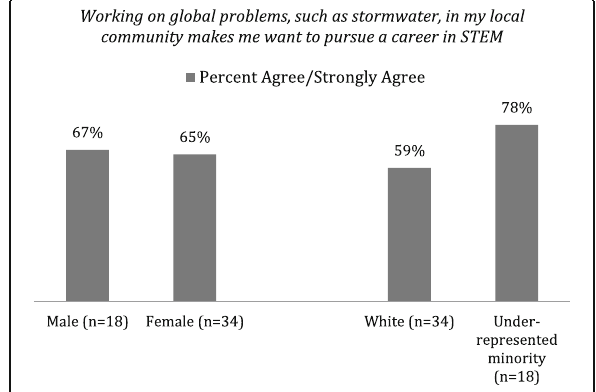
Fig. 7 Survey results for 2015 – 2016 participating HS seniors 1 year after the SMART institute illustrating the perceived importance of community relevance of the